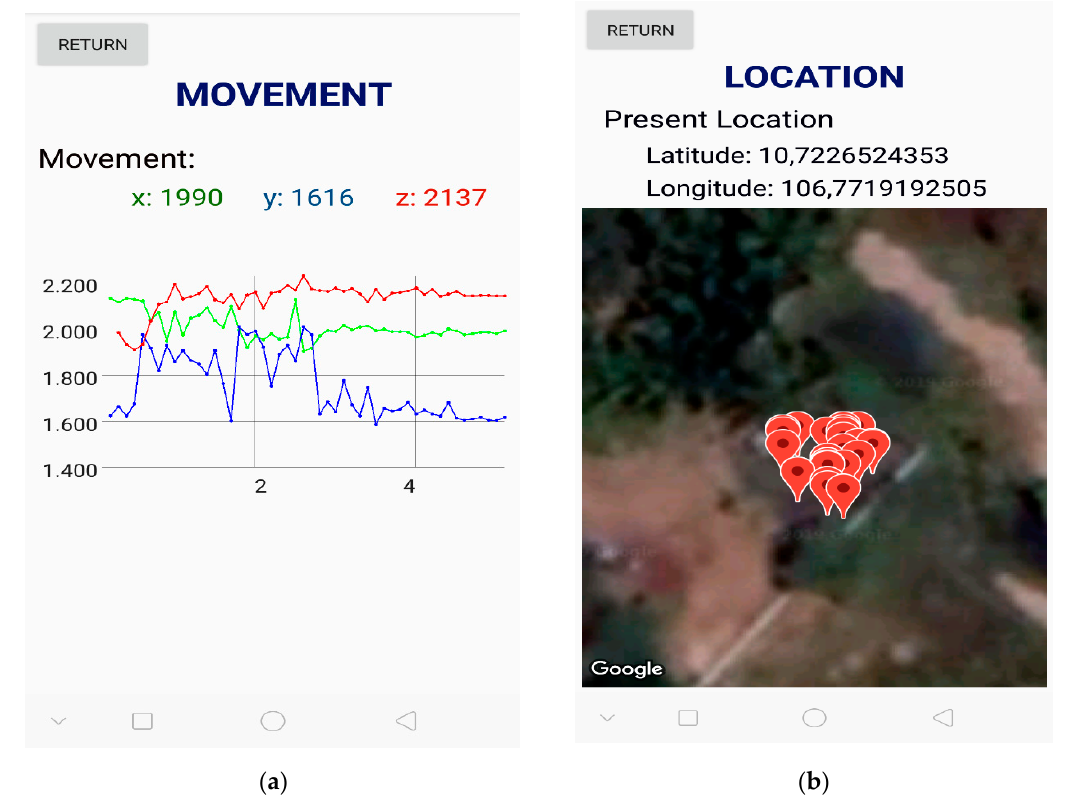
Figure 14. Motion data from the accelerometer ( a ) and the GPS-tracking data ( b ).